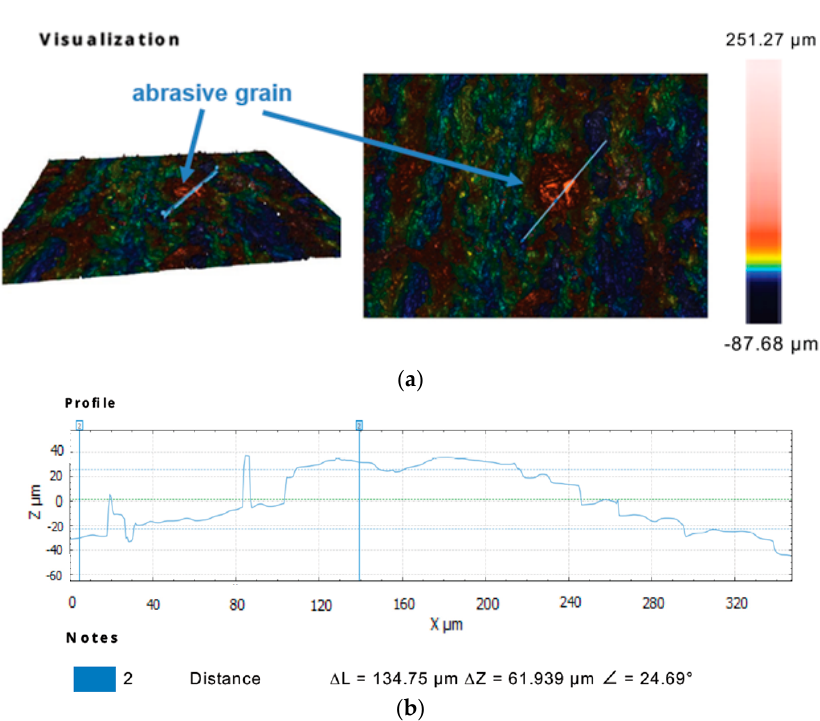
Figure 9. Profile extraction for a cross-section containing a diamond abrasive grain using confocal microscopy: a measurement area with the indicated place of an extracted profile ( a ) and the extracted profile ( b ).